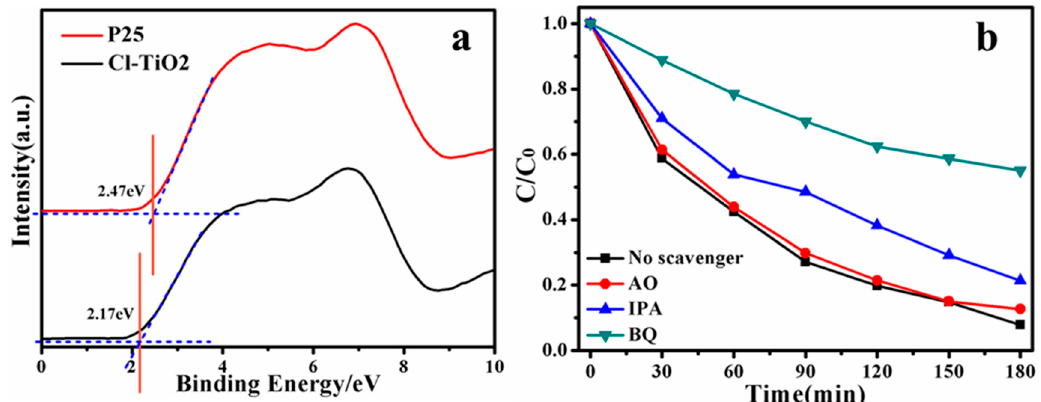
Figure 10. ( a ) VB XPS spectra of P25 and Cl-TiO 2 . ( b ) Photodegradation of MO by composite-coated fabrics in the presence of different capture agents. Catalysts 2020 , 10 , x FOR PEER REVIEW 12 of 17